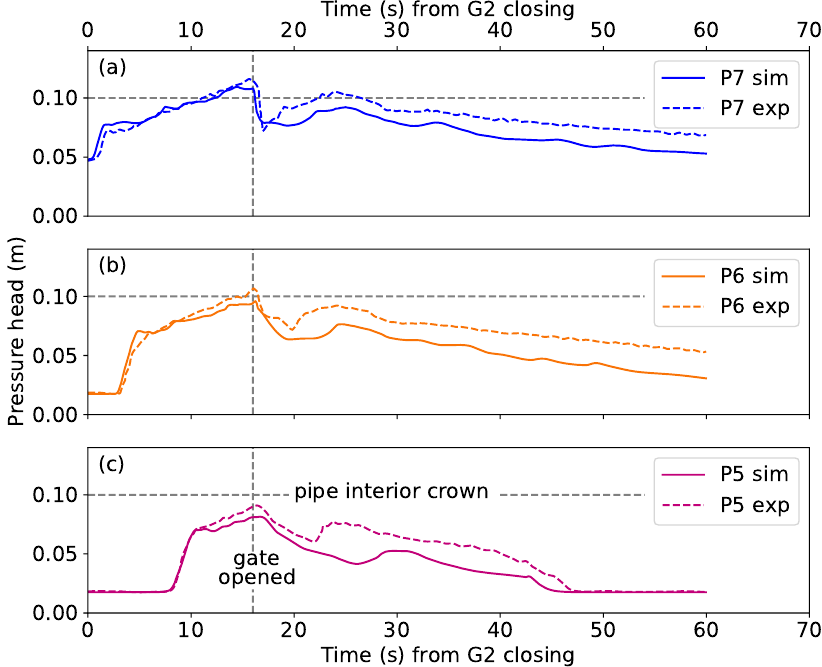
Figure 6. Pressure head at sensors along pipe for Case